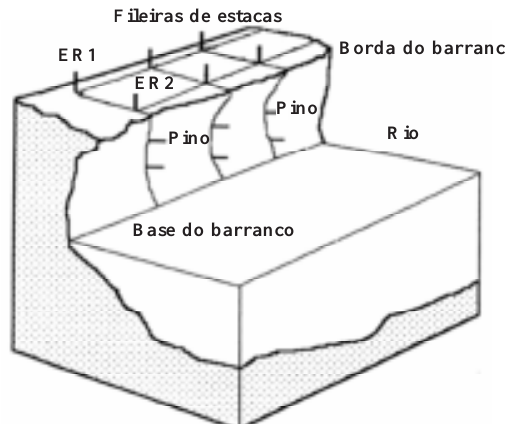
Figura 3. Representação esquemática do método dos pinos e das estacas. (Fonte: Fernandez, 1995, p.33, modificado).